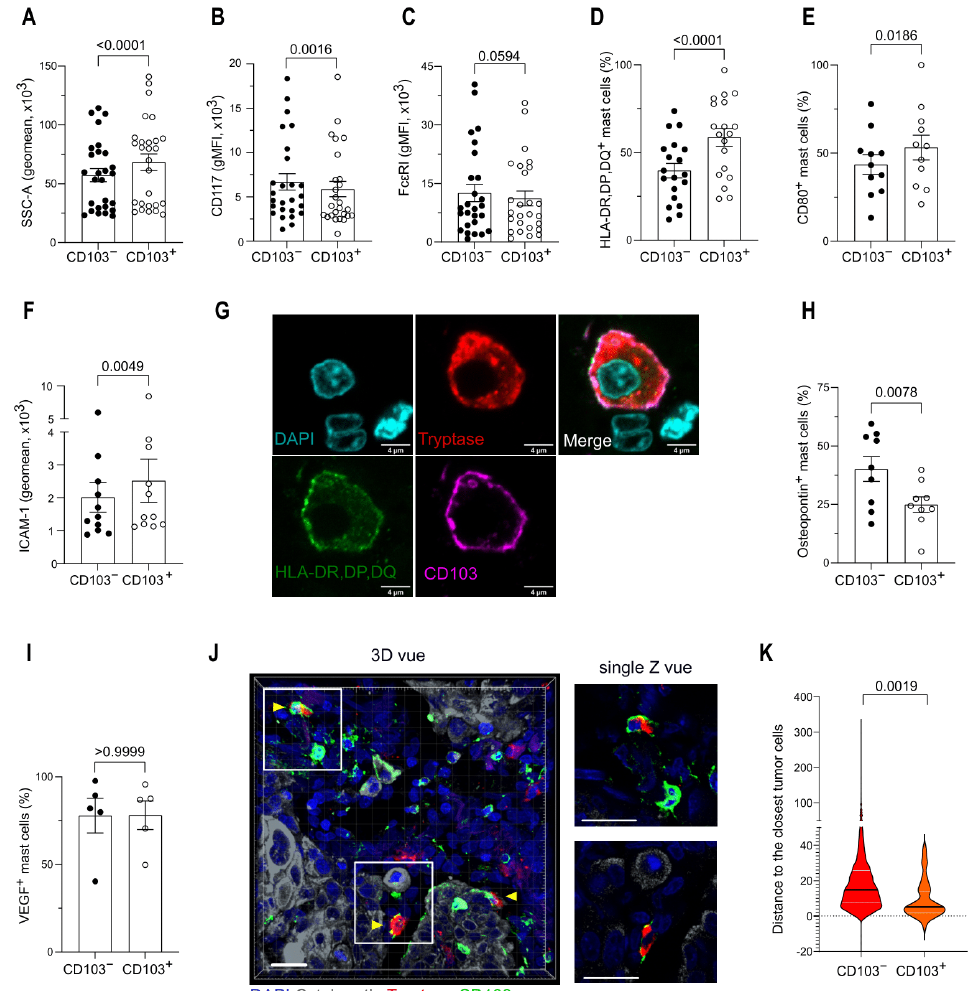
Figure 5. CD103 expression defines two distinct TAMC populations. ( A – C ) Granularity (SSC), CD117, and FceRI expression (gMFI) in CD103 − and CD103 + TAMCs, analyzed by flow cytometry. ( D , E ) Frequency of HLA-DR, DP, DQ, and CD80-positive mast cells for CD103 − and CD103 + TAMCs, analyzed by flow cytometry. ( F ) ICAM-1 expression (gMFI) in CD103 − and CD103 + TAMCs, ana- lyzed by flow cytometry. ( G ) Representative confocal image showing a TAMC stained for DAPI